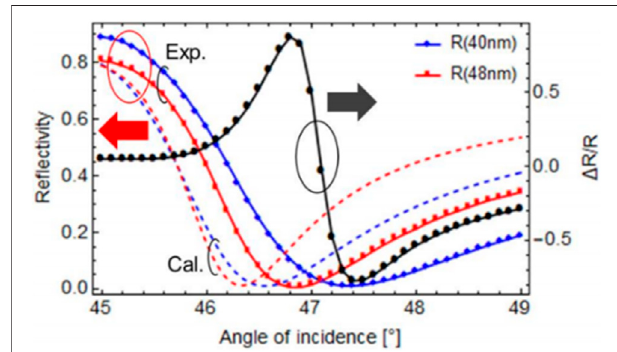
FIGURE 2 | The angular dependence of the re fl ectivity (solid lines) from two regions ( t 2 (cid:2) 40 and t 1 (cid:2) 48 nm) of the wedge-shaped Au thin fi lm (I) and Δ R / R using re fl ectivity of t – Ne laser (wavelength λ (cid:2) 1 and t 2 in air using an He 632.8 nm) as a light source. The calculated re fl ectivities are shown by dotted lines for